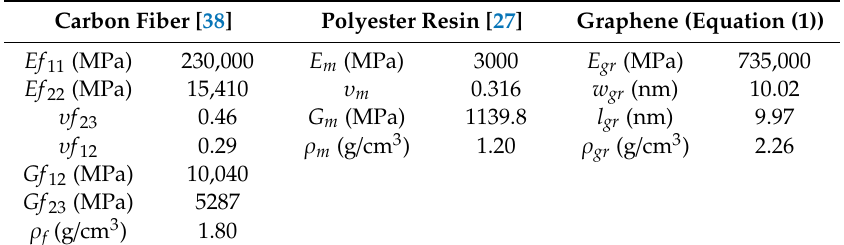
Table 2. Physical properties of components of the composite